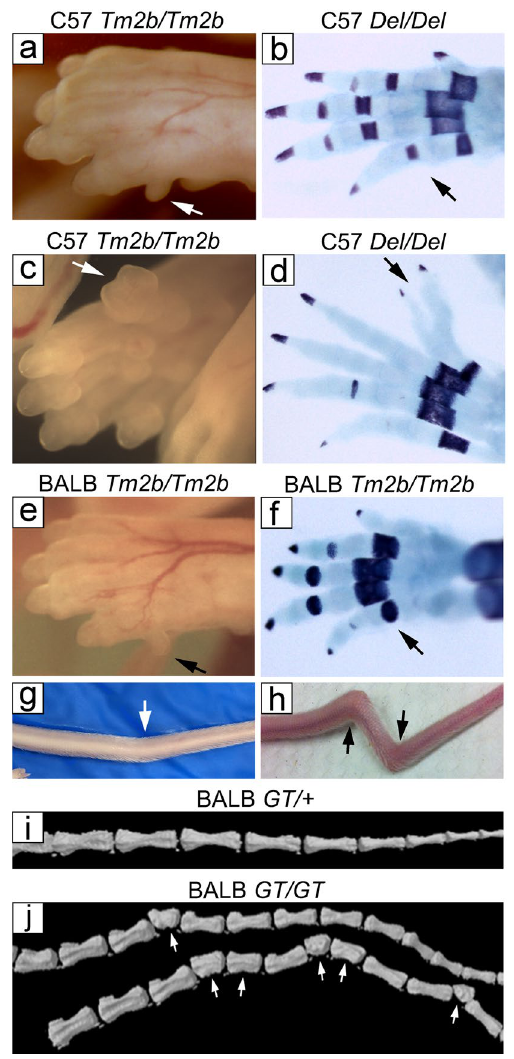
Figure 3. Loss of CECR2 results in skeletal defects. Both post-axial polydactyly of the forelimb and pre-axial polydactyly of the hindlimb were seen in Cecr2 Tm2b/Tm2b embryos on a C57Bl/6N background ( a , c respectively), whereas only post-axial polydactyly of the forelimb was seen in Cecr2 Tm2b/Tm2b embryos on a BALB/cCrlAlt background ( e ). Representative limbs, with defects similar to those pictured in ( a ) ( c ) and ( e ), were stained with Alcian blue and Alizarin red to identify forming cartilage (light blue) and bone (dark staining) respectively ( b , d , f ). Post-axial extra digits did not contain cartilage or bone, but pre-axial extra digits did, formed by bifurcation of the first normal digit ( c , d ). BALB/cCrlAlt Cecr2 GT/GT adults also can show skeletal defects of the tail (arrows), with minor ( g ) and severe kinks ( h ). Compared to a heterozygote with no tail kinks ( i ), micro-CT scans of two mutant tails ( j ) showed intermittent shortened, wedge or hemi-vertebrae